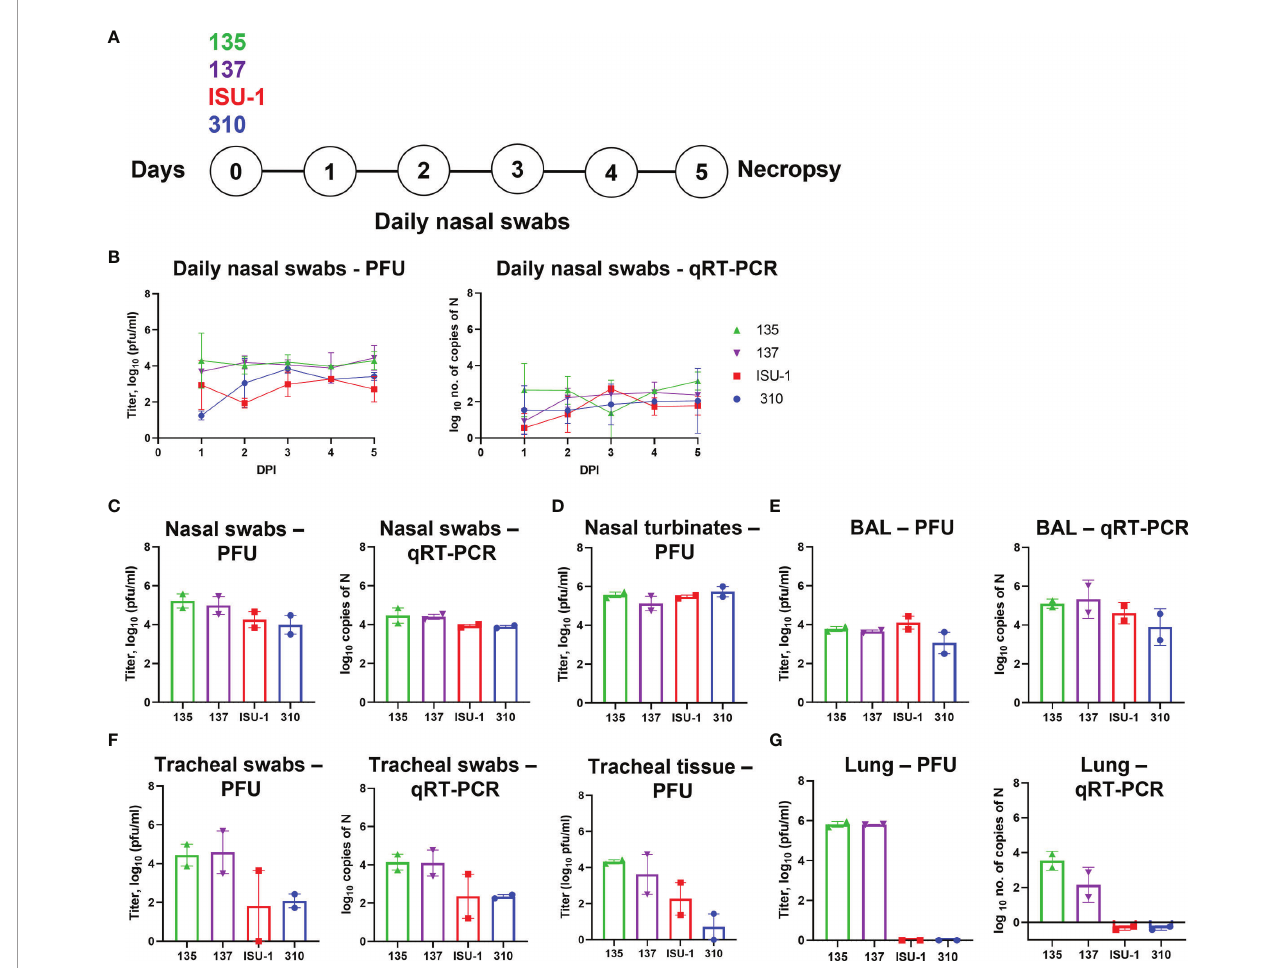
FIGURE 2 | Virus load in tissues after in vivo inoculation with PRCV strains 135, 137, 310 and ISU-1. Experimental design (A) . Two pigs were infected with 2 x 10 7 PFU of either 135,137, ISU-1 or 310. All animals were euthanized fi ve days post infection (DPI). Daily nasal swabs were collected (B) . At post-mortem nasal swab (C) , nasal turbinates (D) , BAL (E) , tracheal swab and tracheal tissue (F) and lung accessory lobe (G) were collected. The quantity of infectious virus in the nasal swabs, 0.5 g nasal turbinates, 1 ml BAL fl uid, tracheal swab, 0.5 g tracheal tissue and 0.5 g lung accessory lobe was determined by plaque assay. For tracheal tissue, a 3 - 4 mm rings were harvested from the top, middle and bottom of the trachea, and 0.5 g of each ring homogenized; each point represents the mean titers from the three